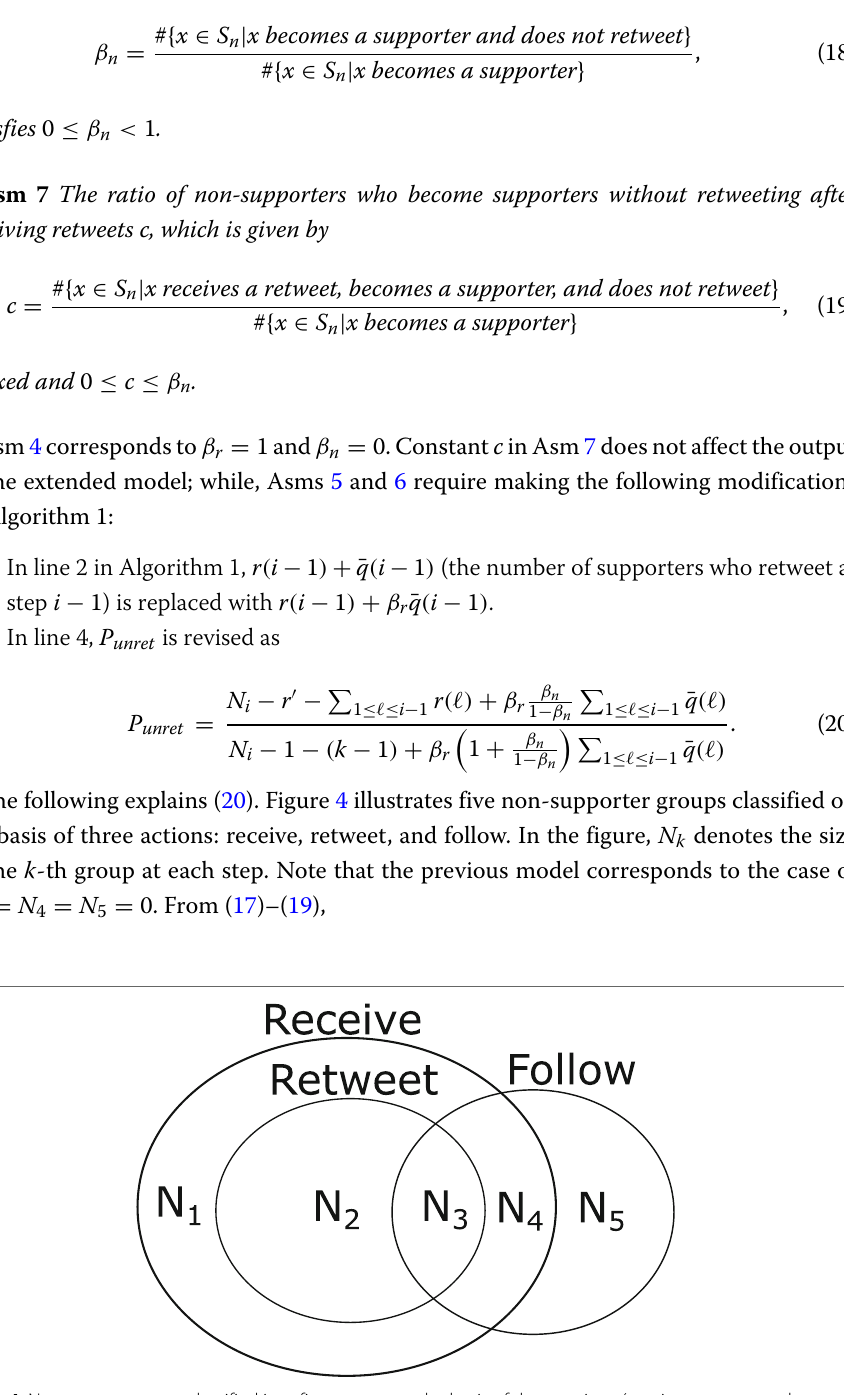
Fig. 4 Non-supporters are classified into five groups on the basis of three actions (receive, retweet, and follow) at each step. N 1 , N 2 , ... , N 5 denote the sizes of these groups (e.g., N 2 non-supporters post retweets and do not become